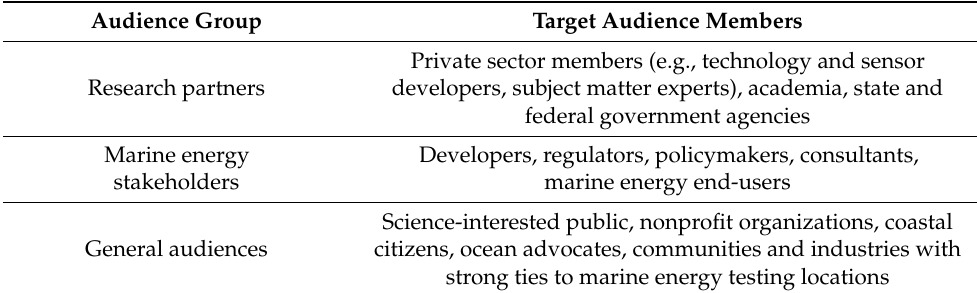
Table 1. Triton Initiative key